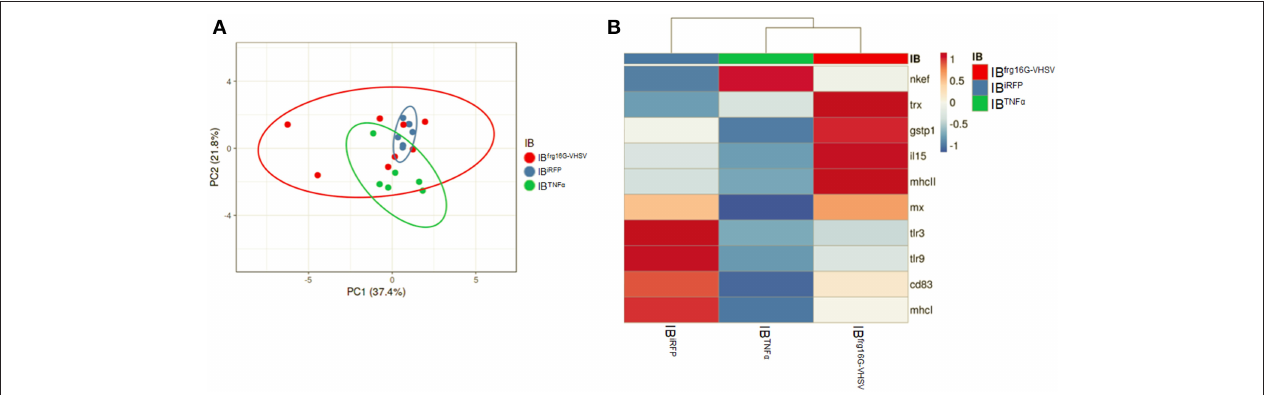
FIGURE 3 | Principal component analysis (PCA) of immune-gene expression evaluation of RBCs stimulated in vitro with 50 µ g/mL of IB iRFP , IB TNF α , or IB frg16G − VHSV , at 24h post-treatment. (A) PCA plot of molecular (gene expression data, 2 − 11 Ct ) signatures of IB iRFP , IB TNF α , or IB frg16G − VHSV treated samples, at 24h post-treatment. Ellipses and shapes show clustering of the samples. (B) Heatmap of molecular (gene expression data, 2 − 11 Ct ) signatures of IB iRFP , IB TNF α , or IB frg16G − VHSV treated samples. Annotations on top of the heatmap show clustering of the samples, mean values. PCA plot and heatmap were performed using Clustvis software. Heatmap data matrix visualizes the values in the cells using a color gradient which gives an overview of the largest and smallest values in the matrix.